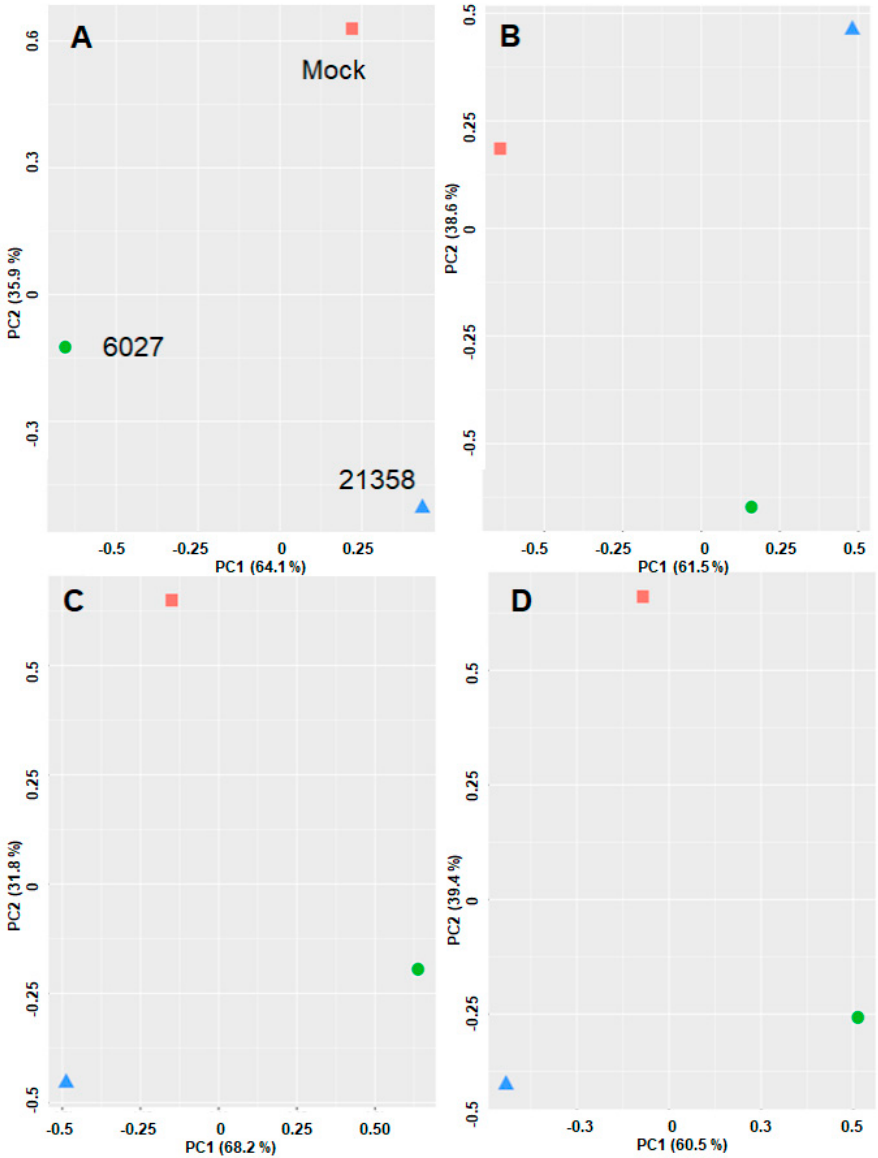
Figure 7. Principal component analysis of affino-proteome data sets from T. gondii RH tachyzoites ( A , B ) and from Mus musculus spleens ( C , D ). Cell-free extracts were prepared and subjected to differential affinity chromatography on mock (red square), peptide 21358 (blue triangle) or peptide 6027 (green circle) columns followed by mass spectrometry as described in the Materials and Methods. ( A , C ), Top3 data; ( B , D ), LFQ data. X-axis, principal component 1; Y-axis, principal component 2.